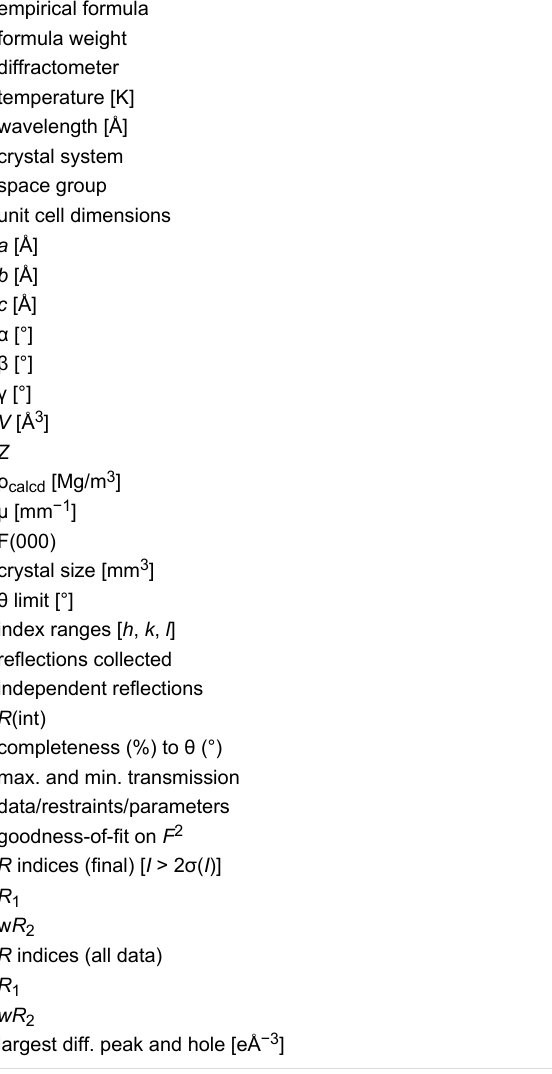
Table 1: Summary of crystallographic data for 1,3,5-(R f6 ) 2 C 6 H 3